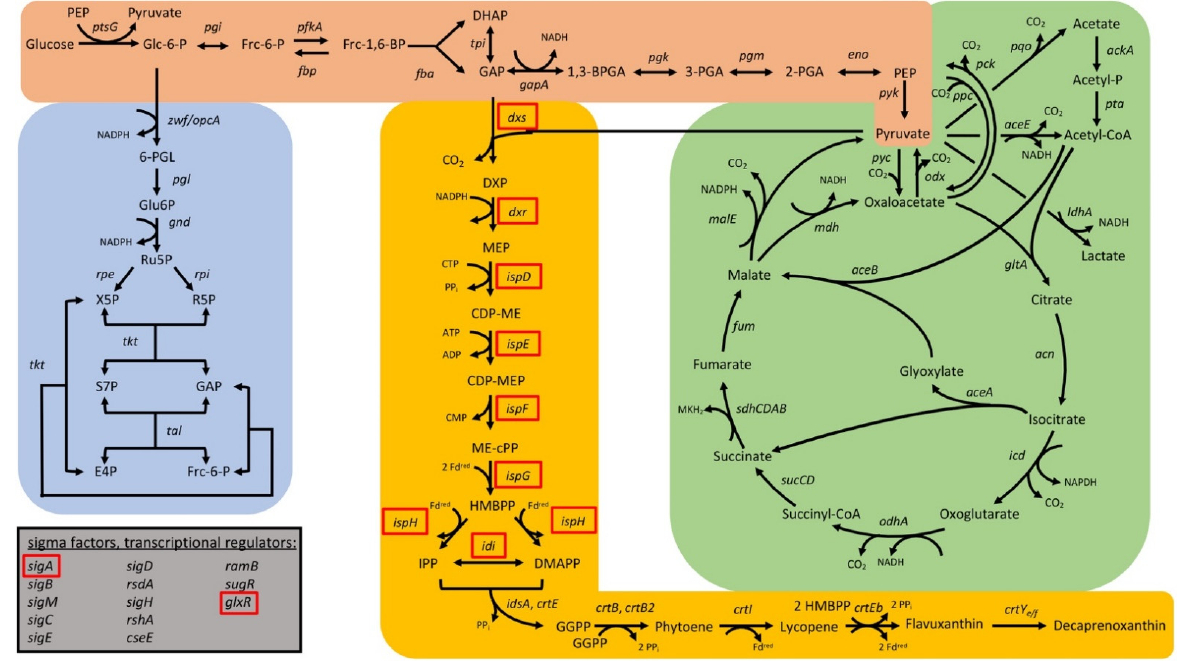
Figure 3. Scheme of the central carbon metabolism and carotenogenesis in C. glutamicum with glycolysis (orange shading), the pentose phosphate pathway (blue shading), the TCA cycle (green shading), as well as the MEP pathway and the carotenogenesis (yellow shading). Gene names are given next to the reactions catalyzed by their gene products. The corre- sponding gene identifiers can be found in Table 1. Essential genes are depicted with a red box. aceA : isocitrate lyase; aceB :